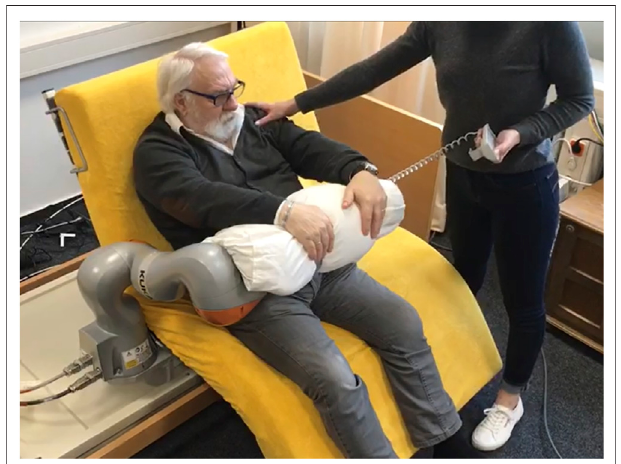
FIGURE4| Schematicofthetrianglerelationshipestablishedamongthe patient, nurse, and robot.